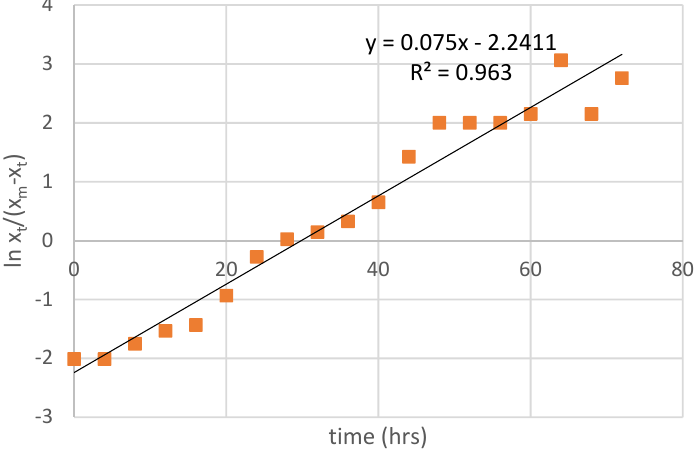
Figure 2. Determination of the maximum specific growth rate ( µ max ) of P. neostrigosus I9 cultured in 1.5 L tomato juice medium (diluted 1:3 v/v) in batch culture at 28 °C and 750 rpm.